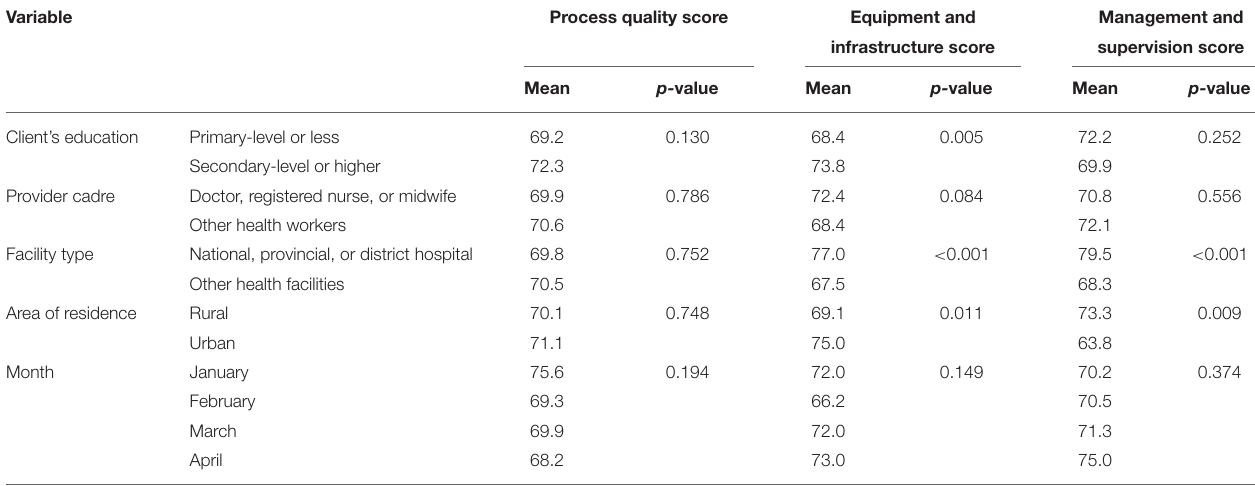
TABLE 9 | Variation in ANC quality by month, client, provider, and facility characteristics.